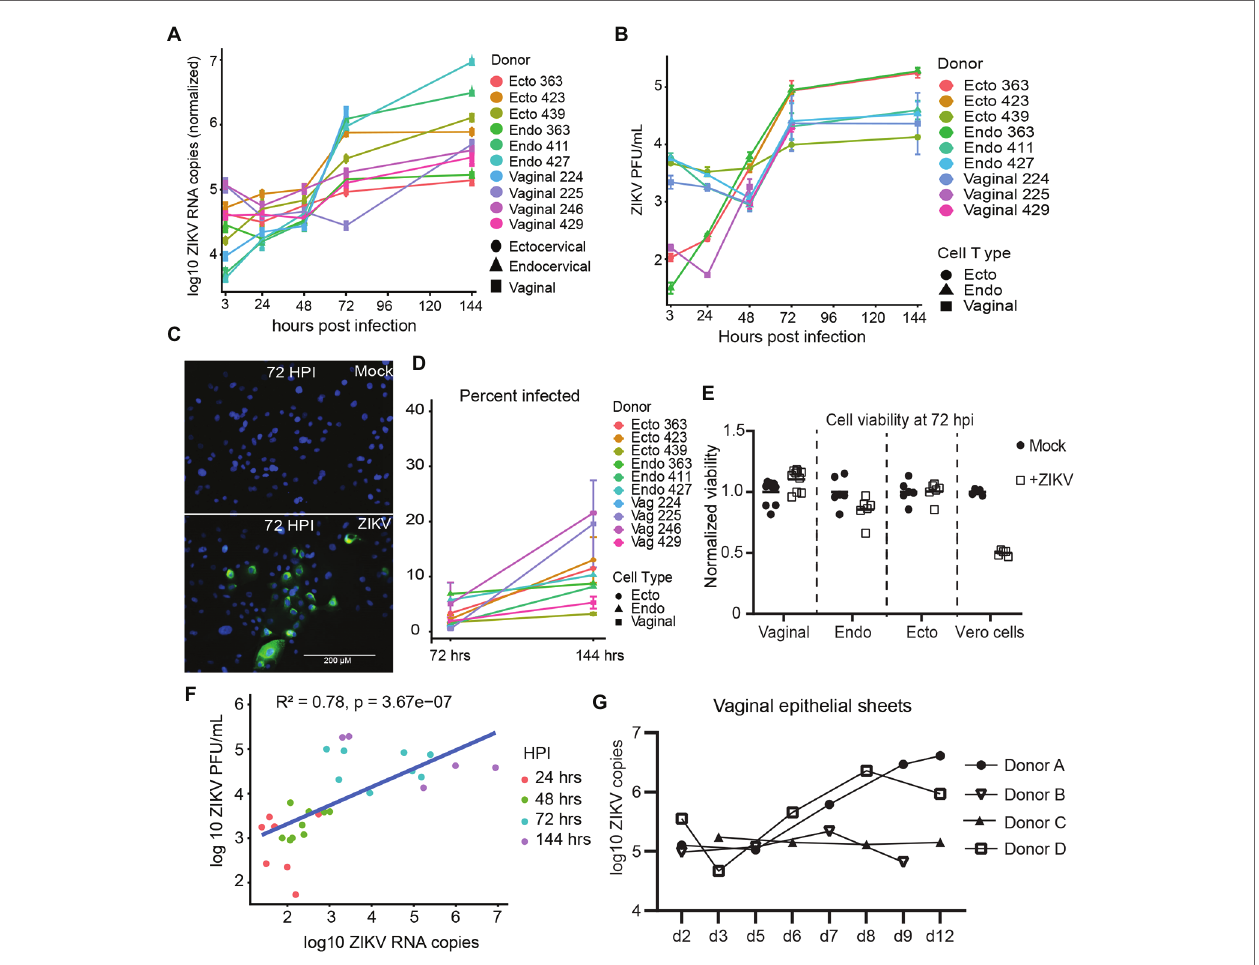
FIGURE 1 | Kinetics of Zika virus (ZIKV) replication in female genital tract epithelial cells and tissue. Epithelial cells were exposed to ZIKV at a multiplicity of infection (MOI) of 1 for 1.5 h, washed, and then cultured. At the indicated time points, cells were processed for quantification of ZIKV infection by multiple methods. (A) RNA from infected cells was reversed transcribed, and copies of ZIKV virus genome and cellular housekeeper RPP30 were quantified by droplet digital PCR (ddPCR). Y-axis indicates the log10 copy number of ZIKV genomes detected in 200 ng of input RNA, normalized to RPP30 levels. Each line is the average results for duplicate wells, error bars are standard deviation, and each color is a separate experiment. (B) Supernatants from infected cells were added to Vero cells for plaque assays as described in Materials and Methods section. Plaque-forming units (PFU) per ml of supernatant averaged over three separate wells are plotted; error bars are standard deviation. (C) Staining for ZIKV envelope protein. At 72 hpi, cells were fixed in 4% paraformaldehyde, permeabilized, stained with anti-flavivirus envelope 4G2, and counterstained with DAPI. One representative of nine separate experiments is shown, (D) Kinetics of the percent of ZIKV-infected cells. At least 500 DAPI+ cells per well were analyzed for ZIKV envelope E protein expression to calculate the percentage of infected cells. Each point is the average of two separate wells, error bars are standard deviation, and each line is a separate experiment. (E) Cell viability was assessed with the Viral ToxGlo assay. Fold difference from the mean of values for mock infected cells is plotted. Vero cells were infected with ZIKV at an MOI of 0.05 and assessed for cytotoxicity at 72 hpi as a positive control. Each point is a separate well. (F) Correlation between ZIKV RNA copies measured by ddPCR and ZIKV PFUs as determined by plaque assay. Data generated from at 48, 72, and 144 hpi time points were pooled for the regression. (G) Epithelial sheets from vaginal tissue were exposed to 500,000 PFU of ZIKV overnight, extensively washed, and cultured for the indicated times. At harvest, total tissue RNA was extracted, and ZIKV genomes quantified by ddPCR and normalized to RPP30 levels. Points are the average of two or three independent wells per